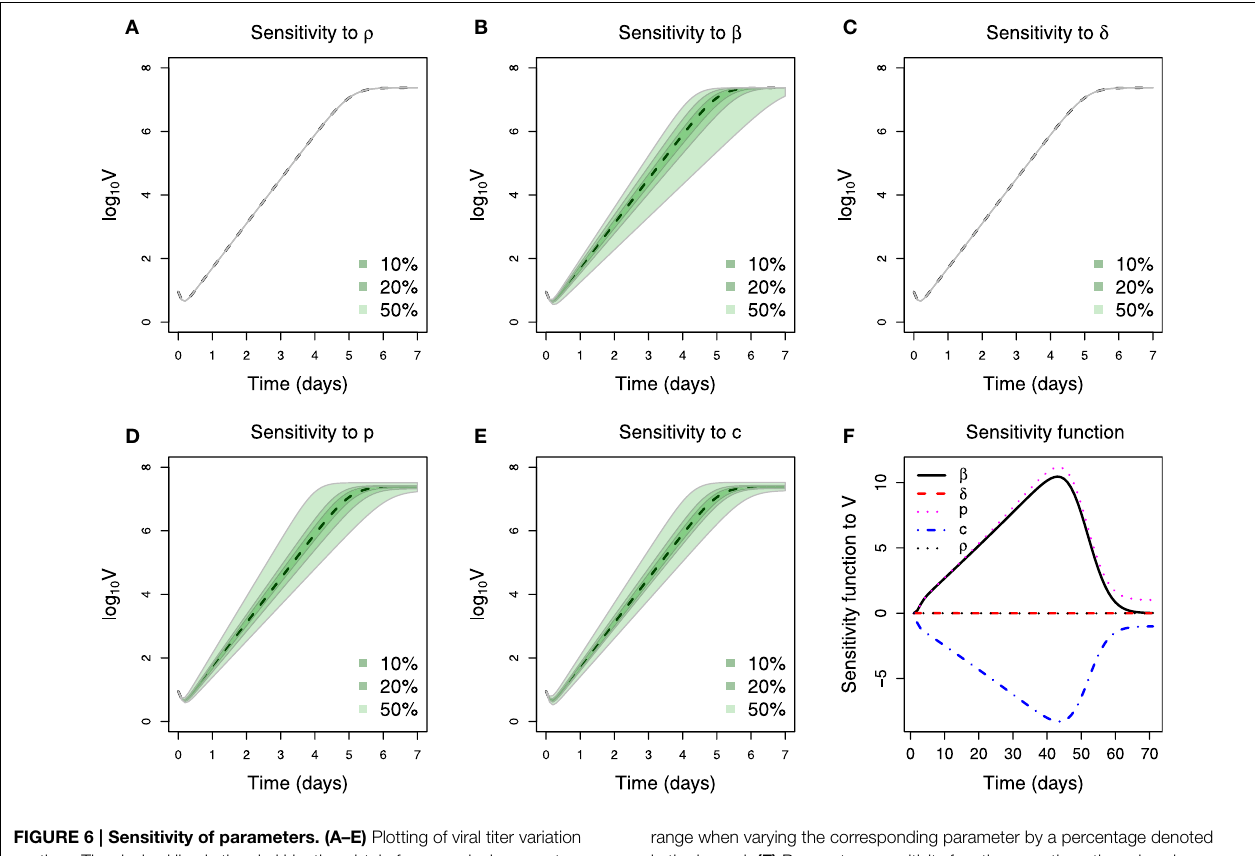
range when varying the corresponding parameter by a percentage denoted in the legend. (F) Parameters sensitivity function over time, the values in y-axis are calculated using Equation